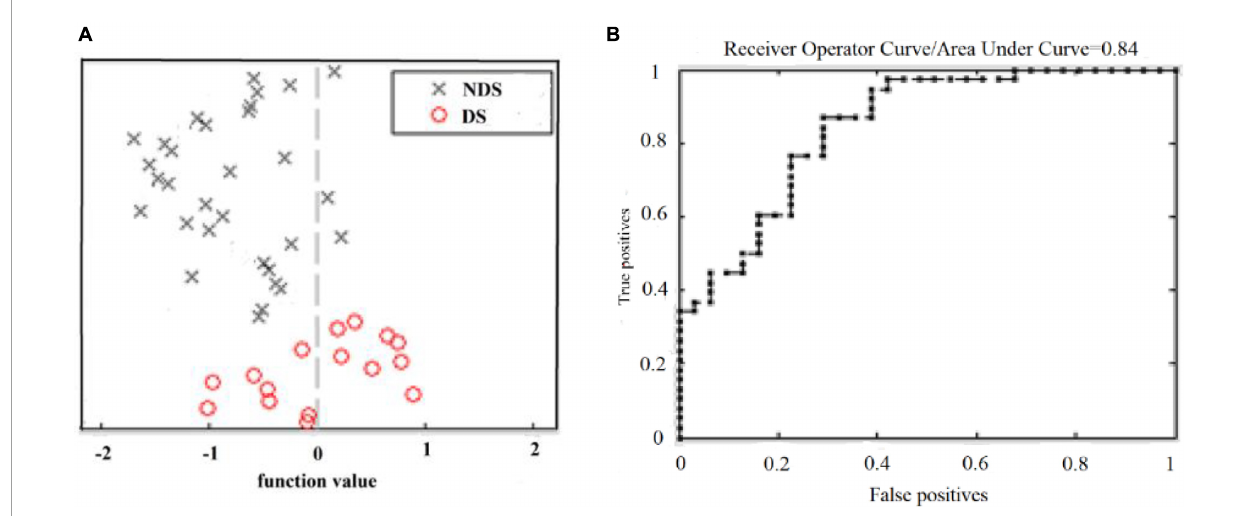
FIGURE1 Classification between DS and NDS based on GMV. (A) Classification plot for training on DS/NDS data and testing on DS/NDS data using GMV. (B) ROC curve obtained by classifying DS and NDS using an SVM classifier. DS, deficit schizophrenia; NDS, non-deficit schizophrenia; GMV, gray matter volume; ROC, receiver operating characteristic curve; SVM, support vector machine.